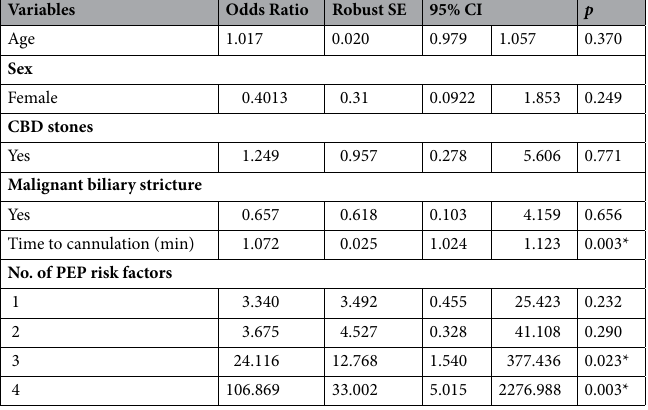
Table 4. Logistic regression to evaluate predictors of pancreatitis. SE: standard error; CI: confidence interval. * p < 0.05.